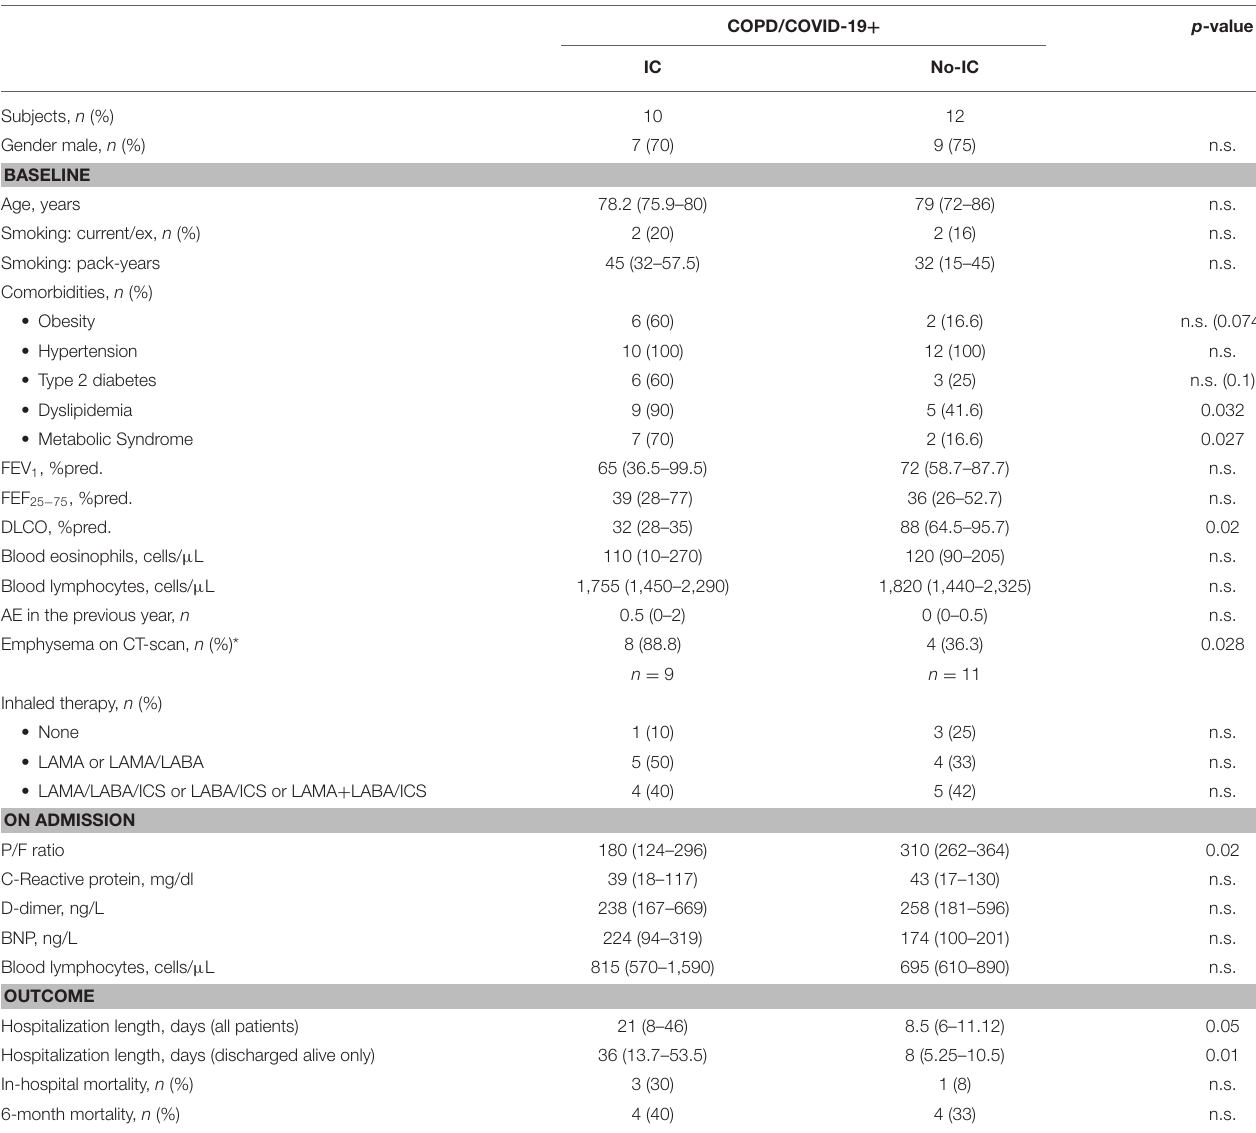
TABLE 2 | Demographic, functional and clinical characteristics of COPD subjects who developed COVID-19 categorized in subjects who needed intensive care (IC) and in those who did not (No-IC).